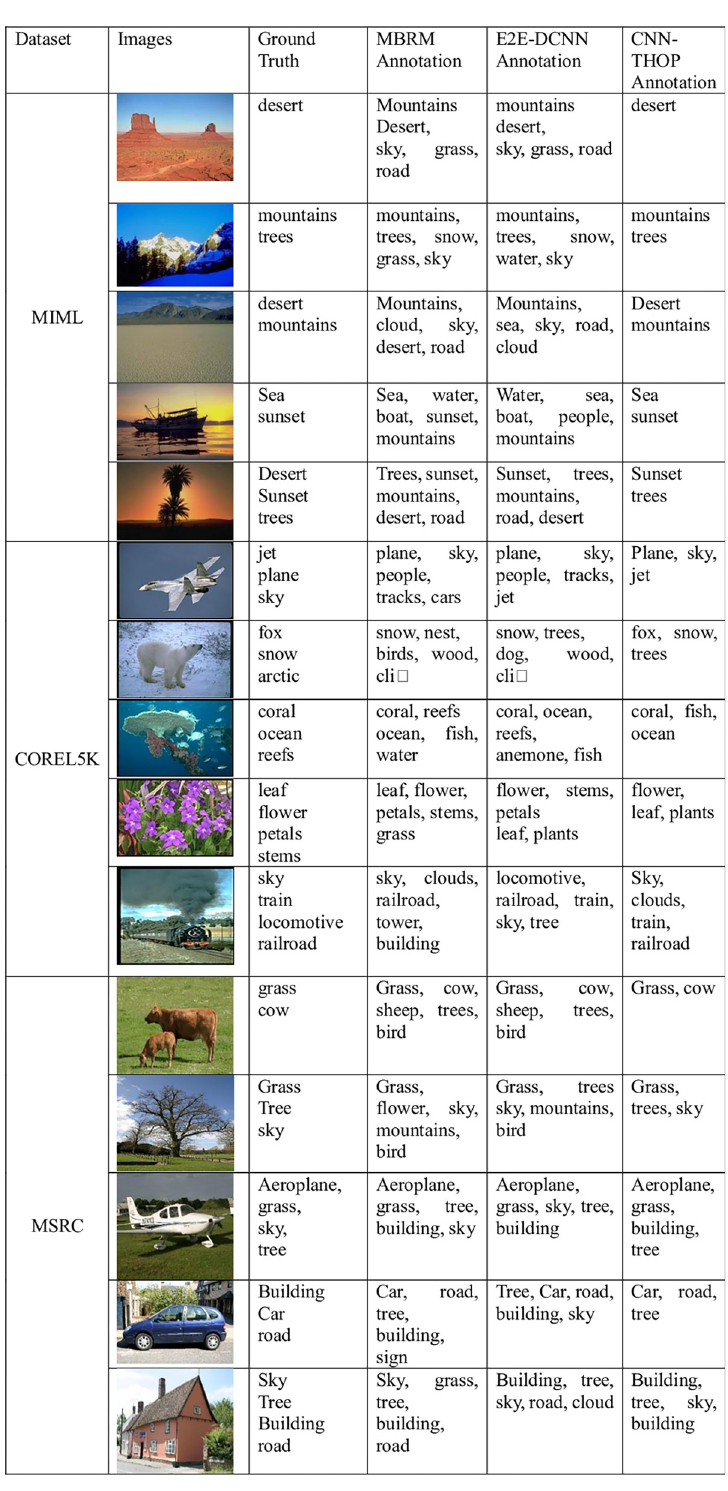
Fig 7. Comparison of image annotation results using various experimental methods.